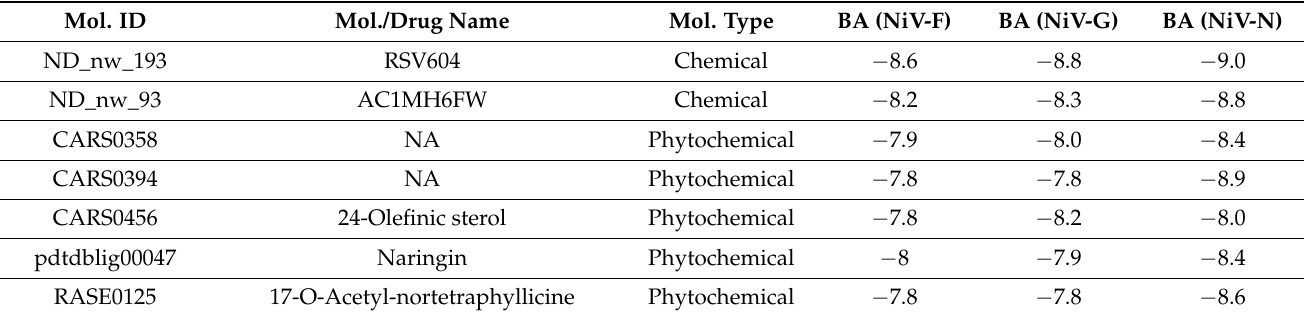
Table 1. Binding affinity (BA, Kcal/mol) values of 8 selected molecules against viral protein targets. Mol. ID Mol./Drug